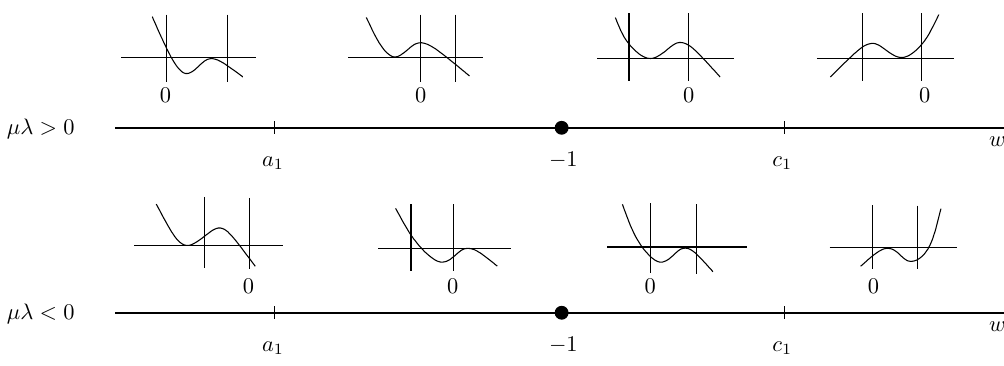
Figure 21. Pro(cid:12)le of the function U (+ ; +) 1 . The vertical line in each potential plot with label 0 denotes the point (cid:27) = 0 and the unlabelled vertical line is the point (cid:27) = (cid:0) (cid:22)